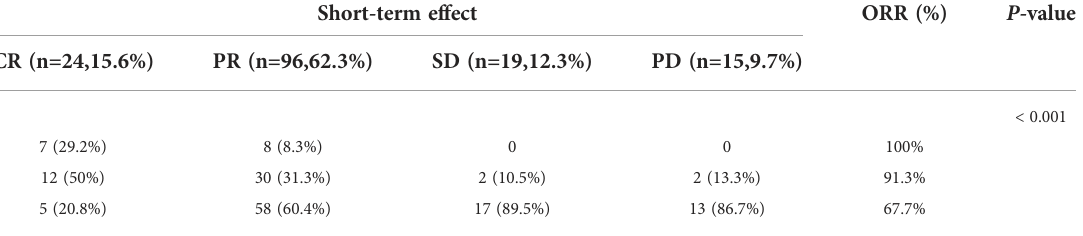
TABLE 2 Short-term effect analysis in different FA